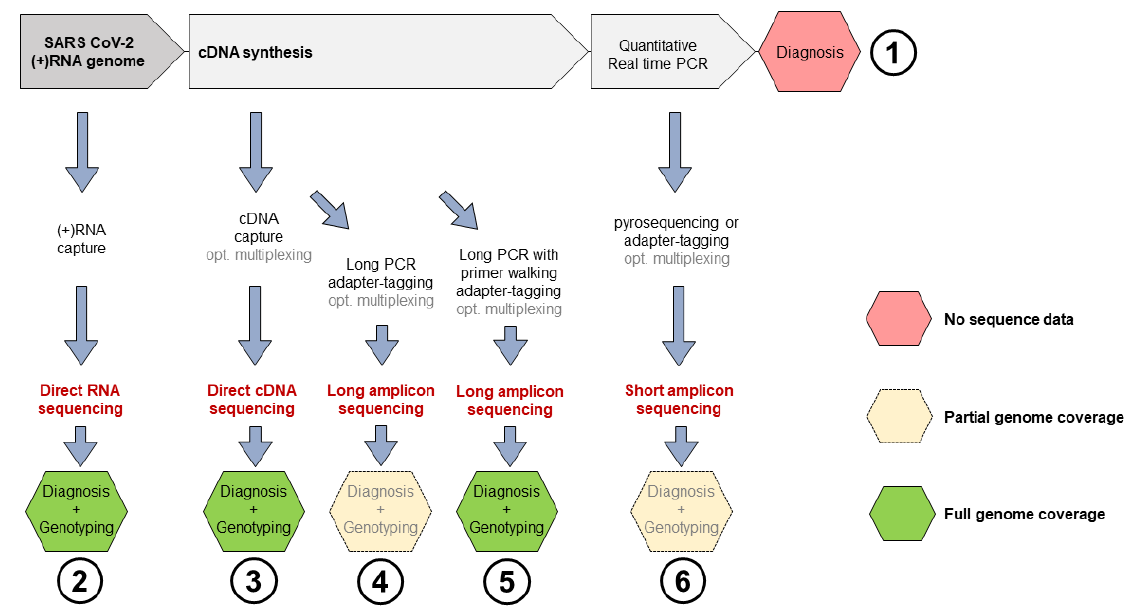
Figure 1. Nanopore sequencing options ( 2 – 6 ) compatible with diagnostic qPCR pipelines ( 1 ). The pyrosequencing option in the path ( 6 ) requires biotin-tagged primers for qPCR [10].